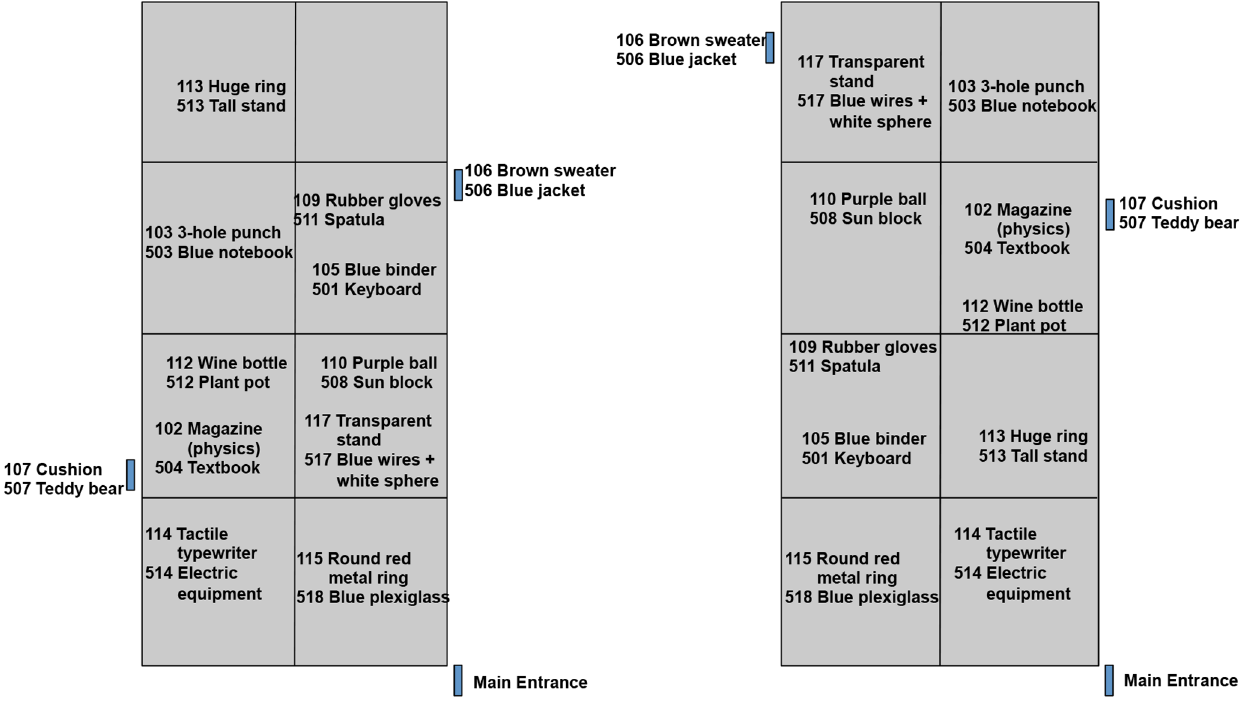
Figure 3. Object layout for the two sets in two counterbalanced maps. Left panel: map 1; right panel: map 2. Each participant only saw one set of objects on the table.